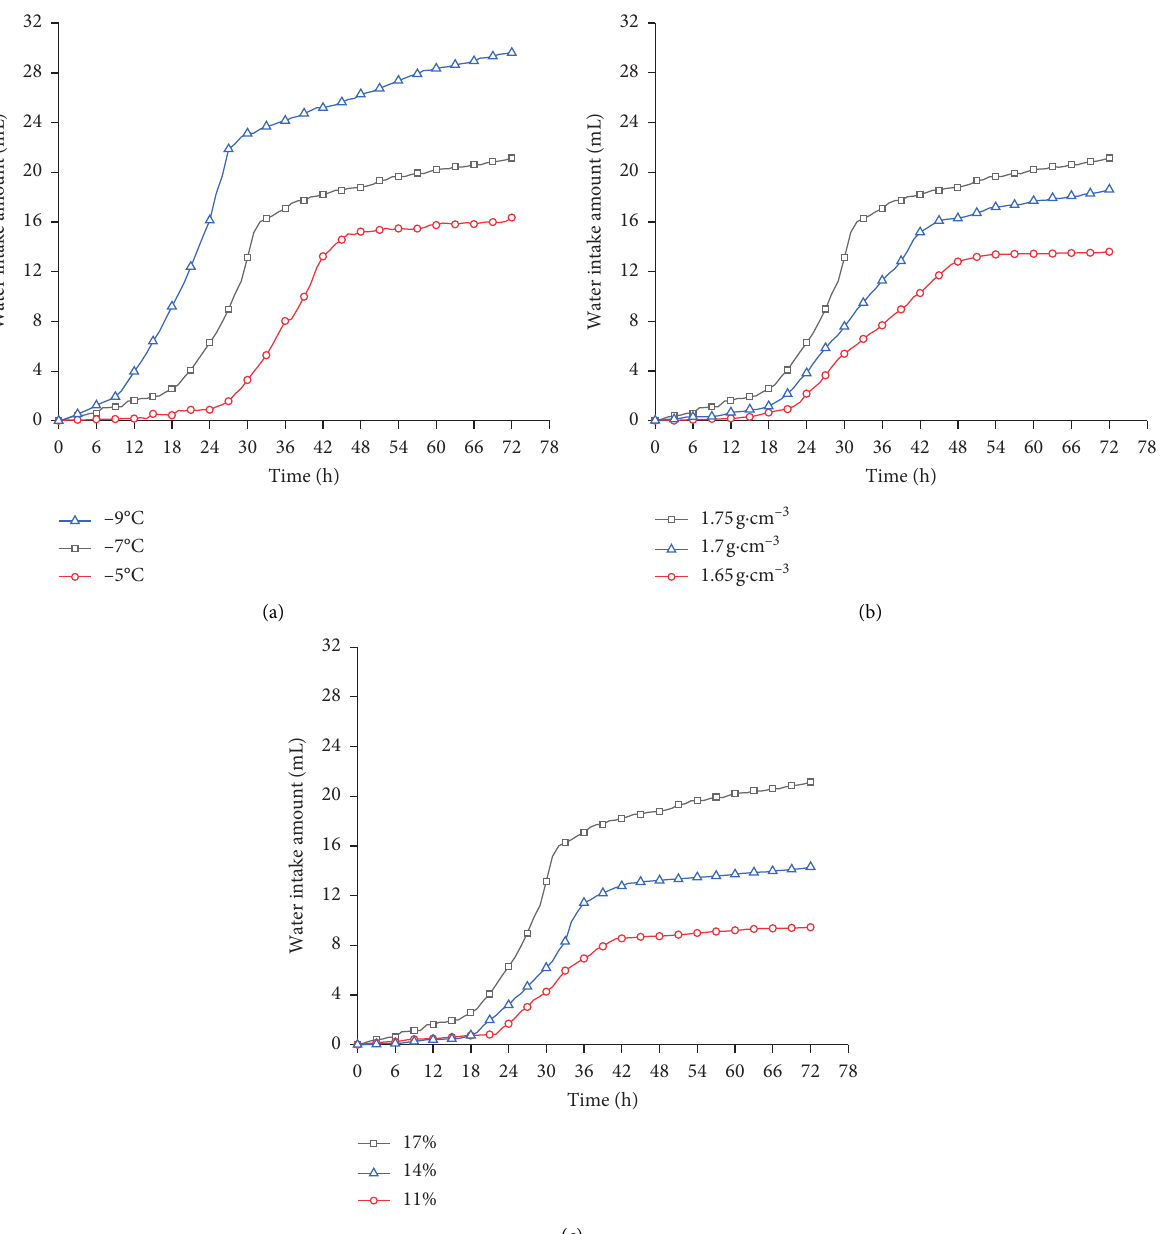
Figure 8: Water intake amounts under (a) different top-plate temperatures, (b) dry densities, and (c) initial moisture